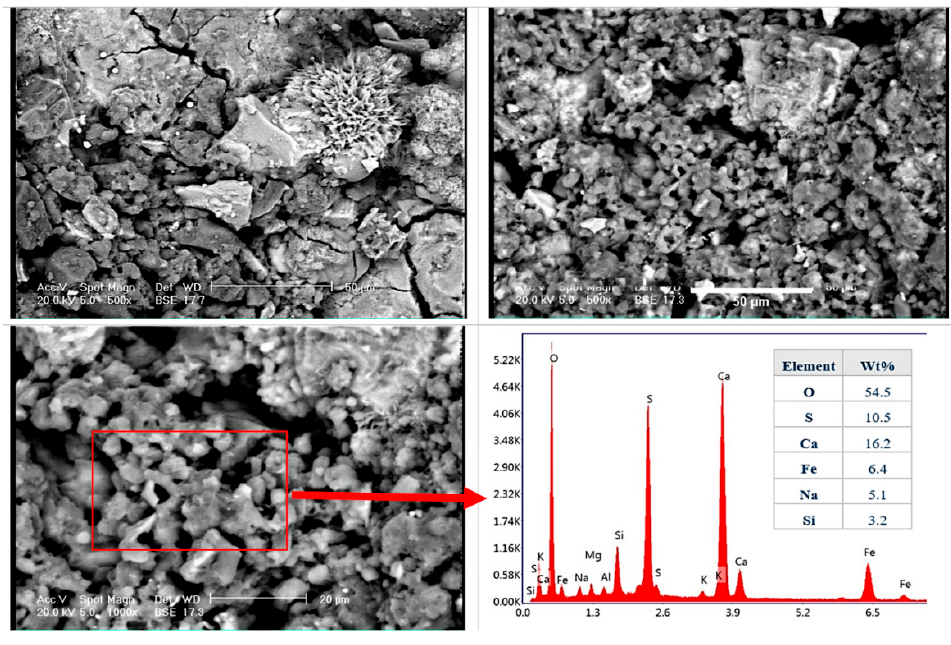
Figure 7. Examples of SEM images of biofilms together with EDS analysis.